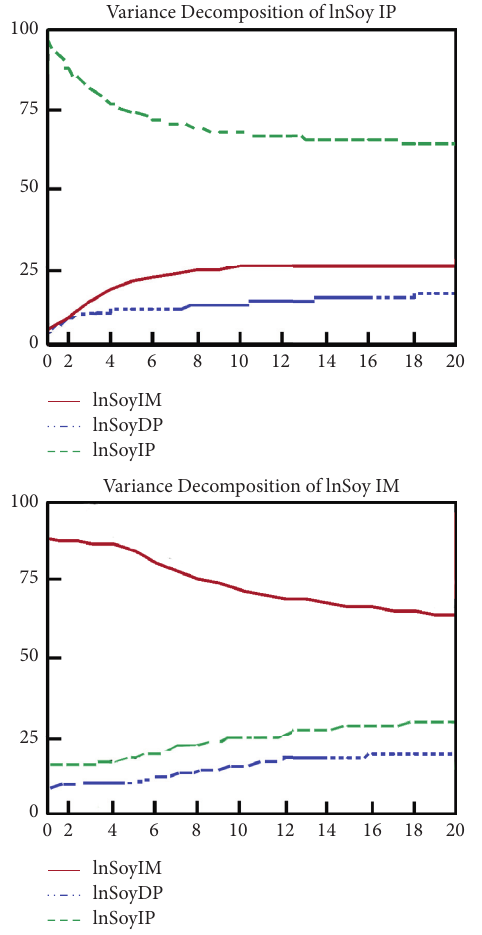
Figure 13: Variance decomposition analysis results for